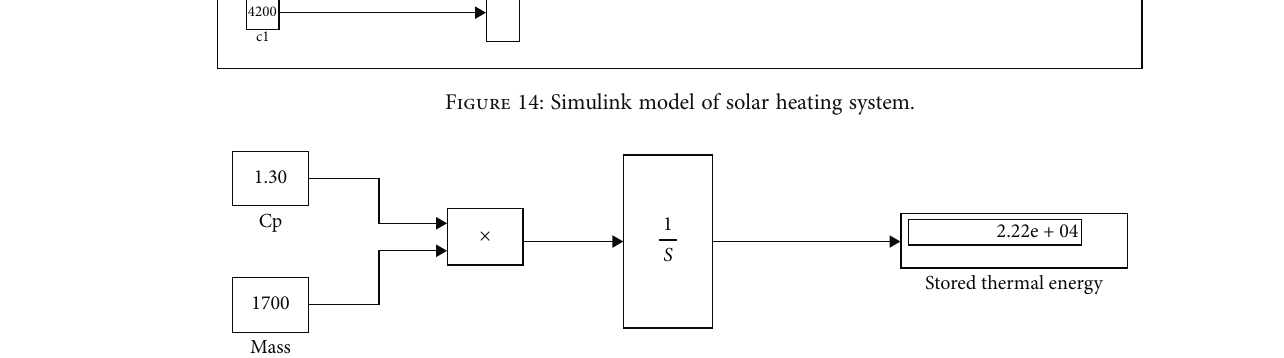
Figure 15: Simulink model of thermal storage.